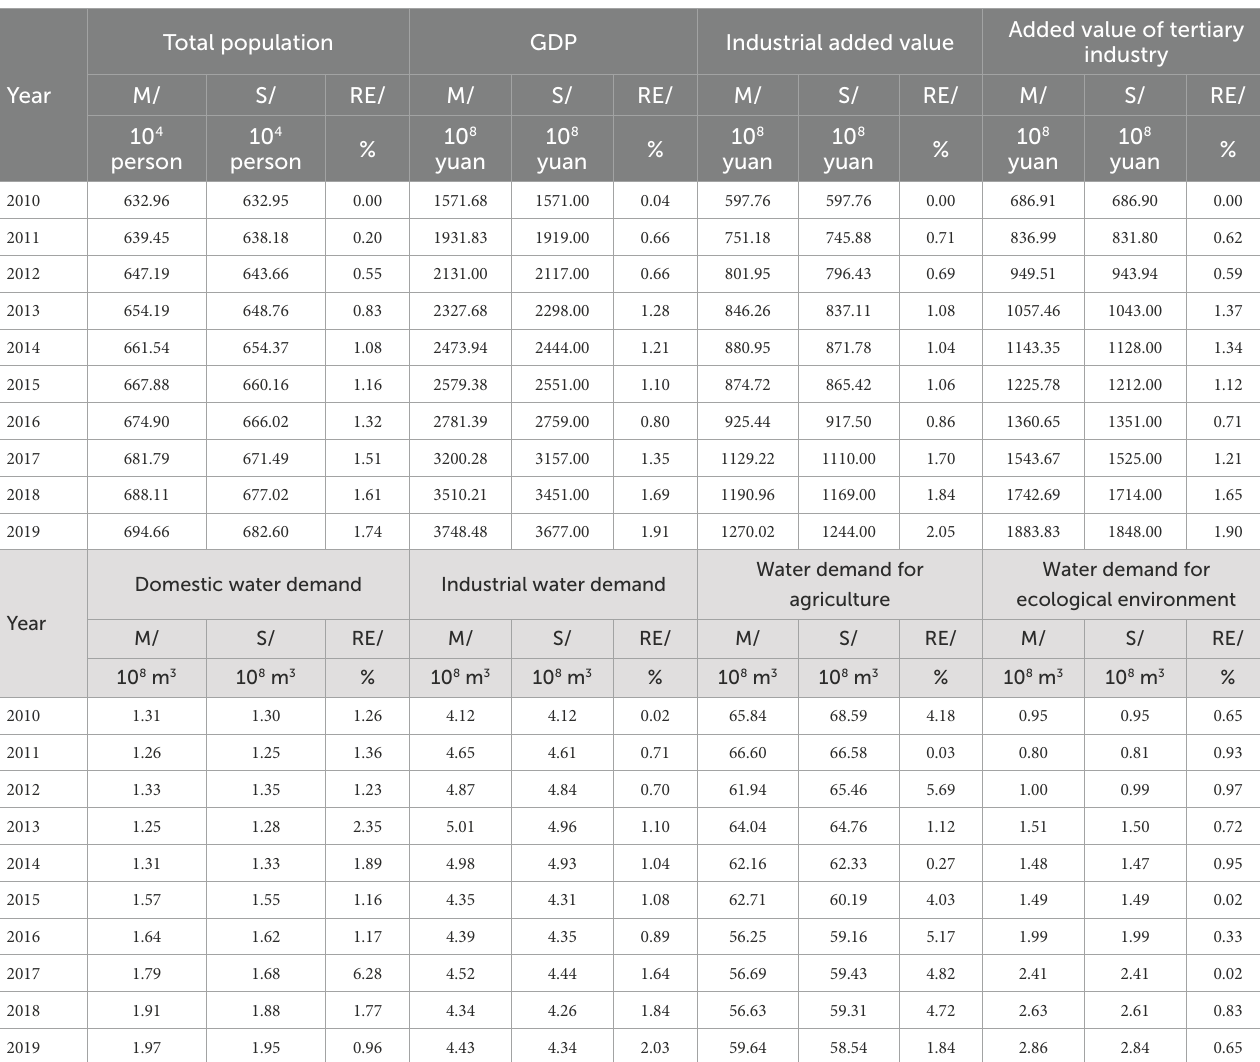
TABLE 3 Test results for model